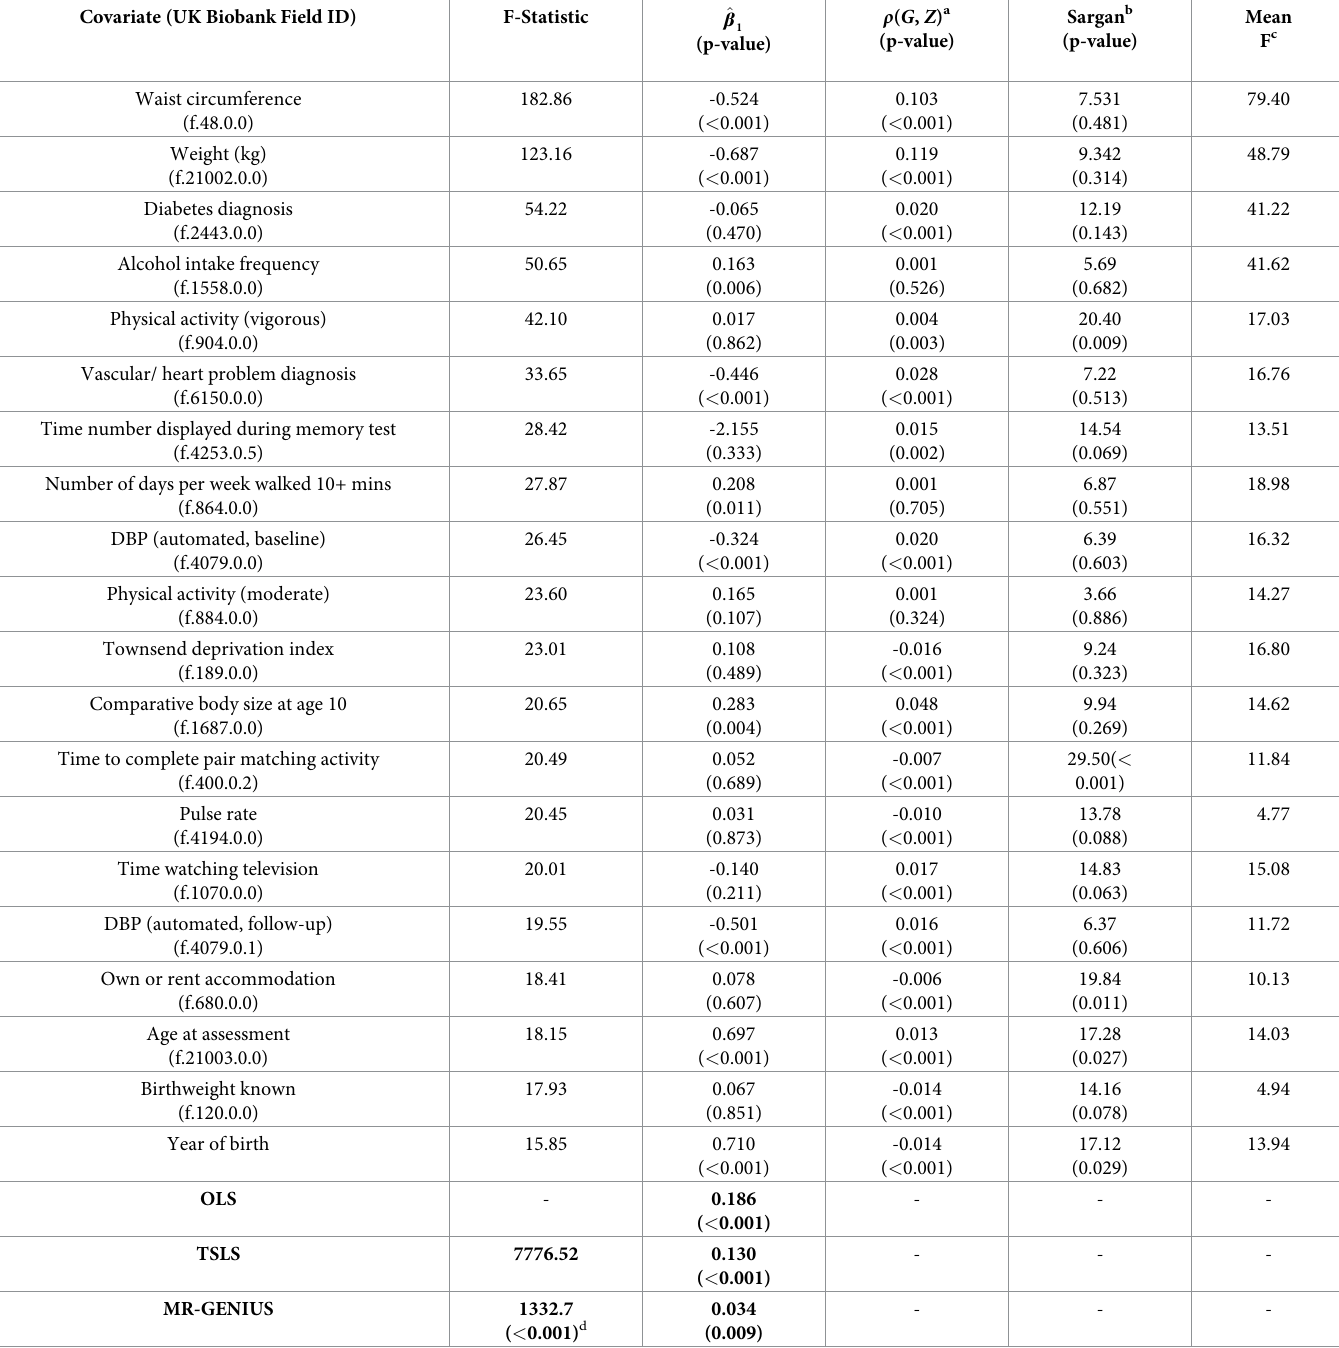
Table 5. MR-GxE estimates and sensitivity analyses using each candidate interaction covariate and MR-GENIUS. Covariate (UK Biobank Field